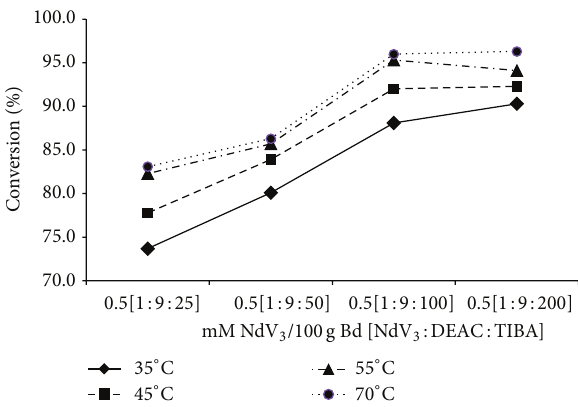
Figure 1: Effect of TIBA and the reaction temperature on monomer conversion.